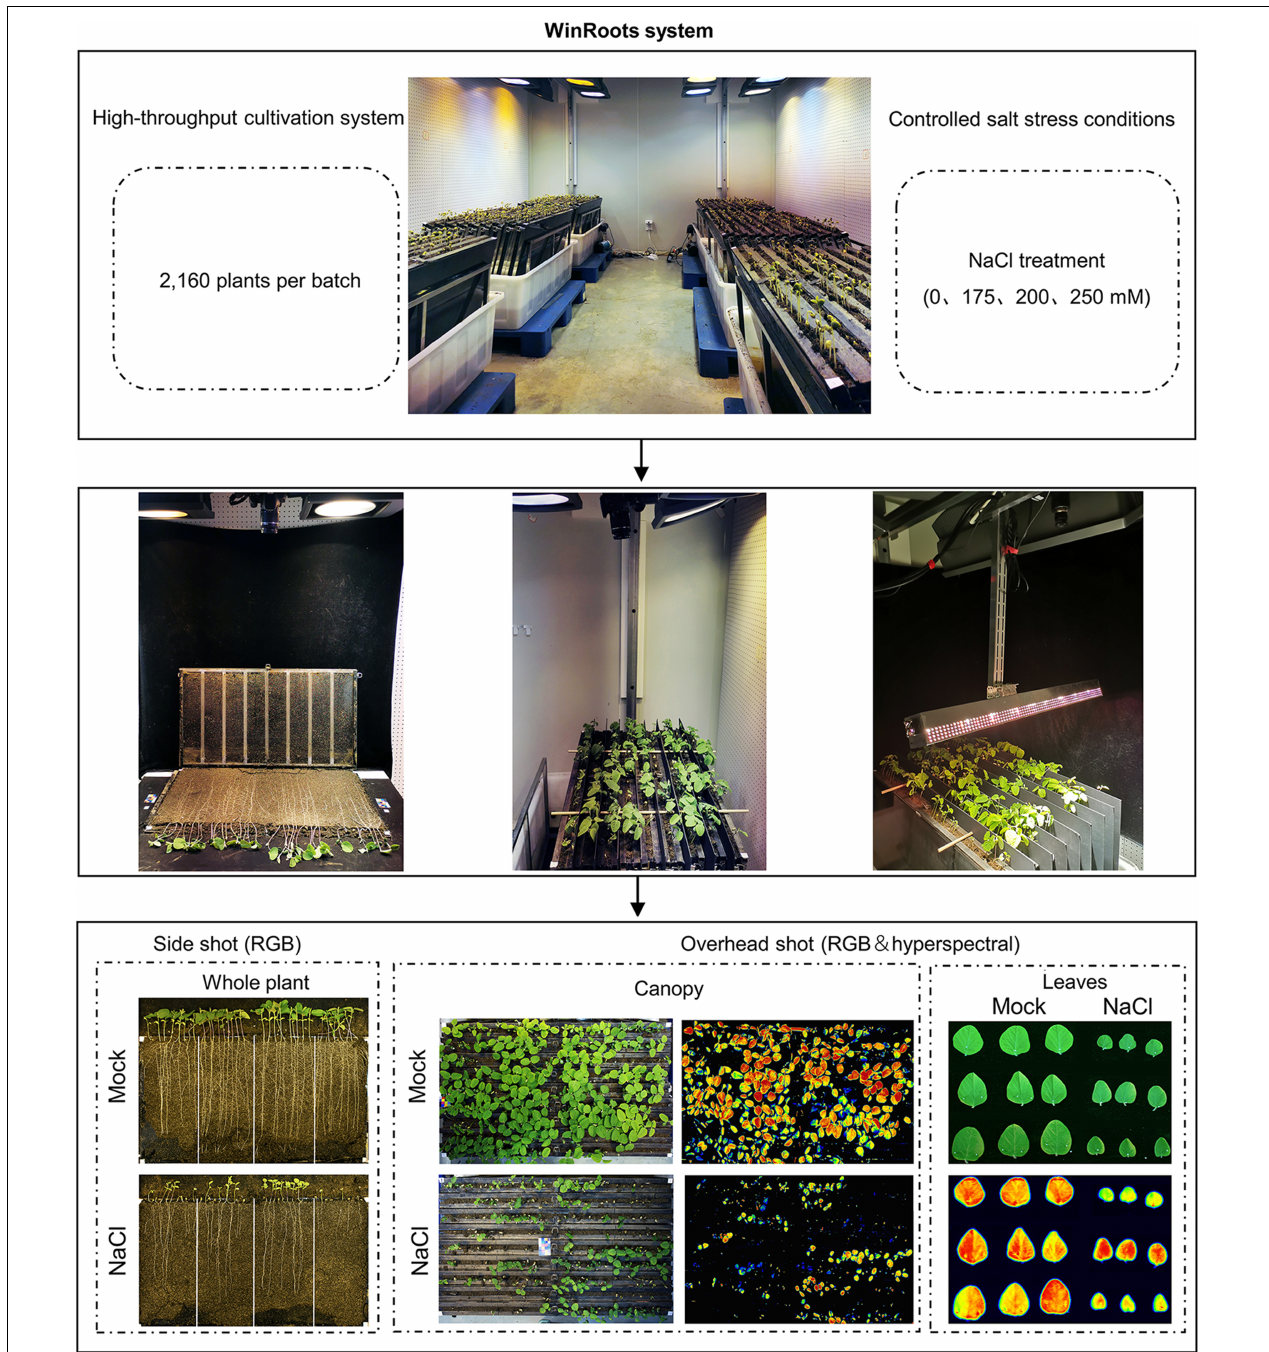
FIGURE 1 | The WinRoots system: a soil-based, high-throughput plant culture platform for phenotyping roots and whole plants. Schematic representation of the usage of the system.